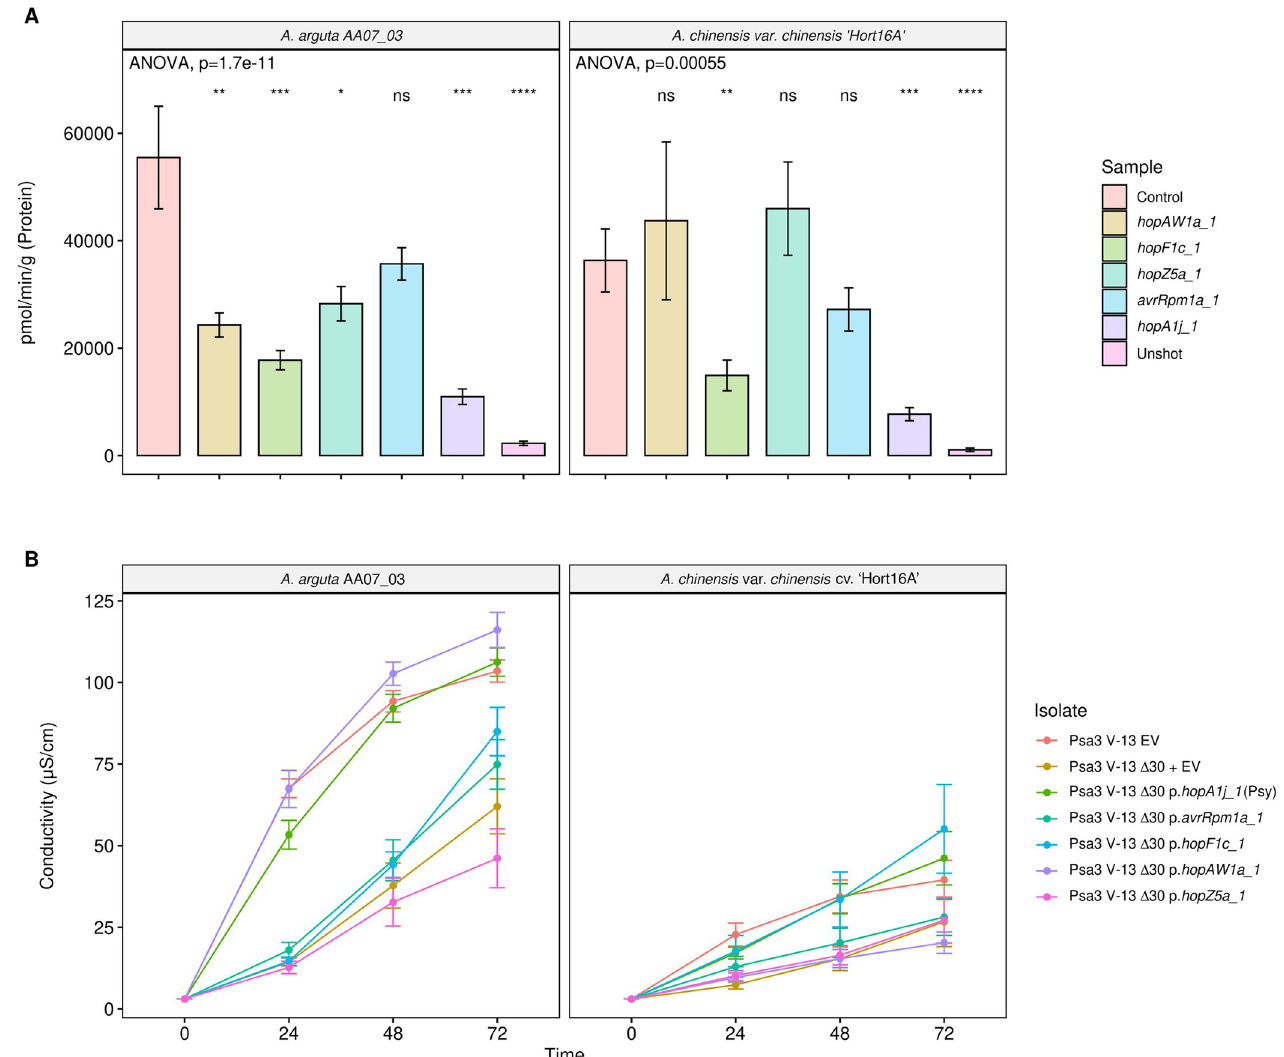
Fig 5. Reporter eclipse assays demonstrate that HopAW1a, HopZ5a, and AvrRpm1a trigger a host-specific immunity response in Actinidia arguta partially supported by ion leakage assays. (A) Avirulence effectors cloned in binary vector constructs tagged with GFP, or an empty vector (Control), were co-expressed with a β -glucuronidase (GUS) reporter construct using biolistic bombardment and priming in leaves from A . arguta AA07_03 or A . chinensis var. chinensis ‘Hort16A’ plantlets [35]. The GUS activity was measured 48 hours after DNA bombardment. Error bars represent the standard errors of the means for three independent biological replicates with six technical replicates each (n = 18). HopA1j from Pseudomonas syringae pv. syringae 61 was used as positive control and un-infiltrated leaf tissue (Unshot) as a negative control. Tukey’s HSD indicates treatment groups which are significantly different at α � 0.05 with different letters. (B) Leaf discs from A . arguta AA07_03 and A . chinensis var. chinensis ‘Hort16A’ plantlets were vacuum-infiltrated with P . fluorescens PF0-1 wild-type strain (Pfo(WT)) or P . fluorescens PF0-1 carrying an artificial type III secretion (Pfo(T3S)), carrying empty vector (EV), or a plasmid-borne type III secreted effector ( hopAW1a , hopZ5a , avrRpm1a or hopF1c , or positive control hopA1j from P . syringae pv. syringae 61) inoculum at ~5 x 10 8 cfu/mL. Electrical conductivity due to HR-associated ion leakage was measured at indicated times over 48 hours. The ion leakage curves are faceted by plant species and stacked for three independent runs of this experiment. Error bars represent the standard errors of the means calculated from the five pseudobiological replicates per experiment (n = 15). Leaf discs from A . arguta AA07_03 and A . chinensis var. chinensis ‘Hort16A’ plantlets were vacuum-infiltrated with Psa3 inoculum at ~5 x 10 8 cfu/mL. Electrical conductivity due to HR-associated ion leakage was measured at selected time points over 48 hours. The ion leakage curves are faceted by plant species and stacked for three independent runs of this experiment. Error bars represent the standard errors of the means calculated from the five pseudobiological replicates per experiment (n = 15).